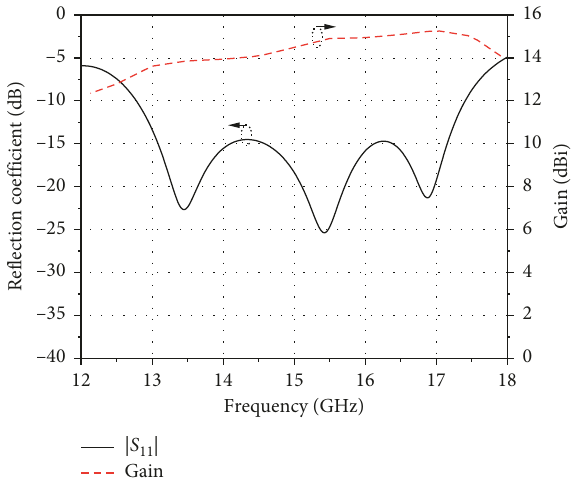
Figure 12: Simulated results of the proposed 2 × 2